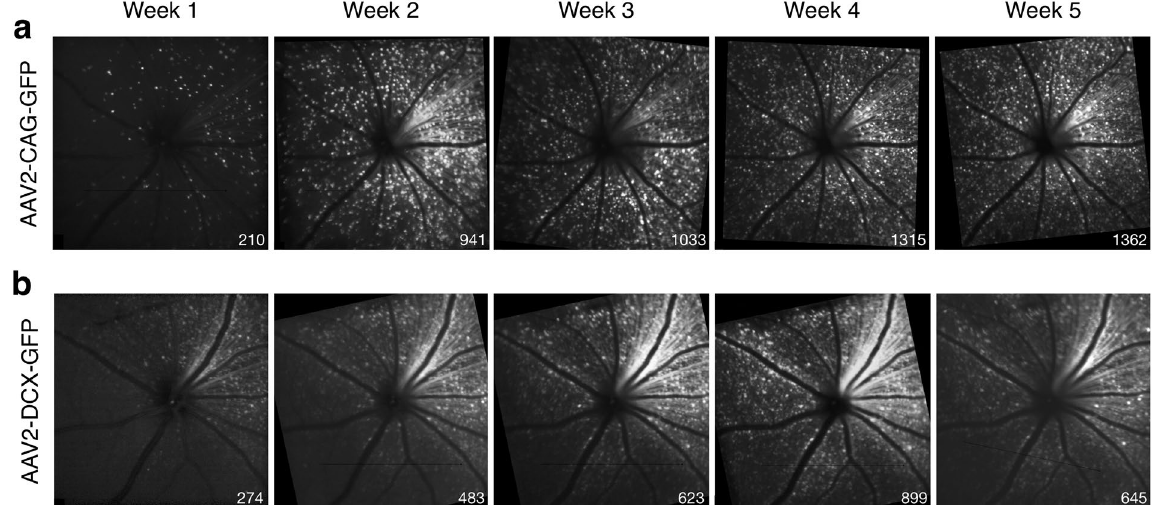
Figure 1. Longitudinal in vivo CSLO images of a mouse retina post-injection of AAV vectors. Fluorescence confocal scanning laser ophthalmoscopy (CSLO) images from the same animal and acquired sequentially up to 5-weeks following intravitreal injection of ( a ) AAV2-CAG-GFP and ( b ) AAV2-DCX-GFP. Images were acquired with a 488 nm excitation laser. Cell counts are shown for each fluorescence image (bottom right